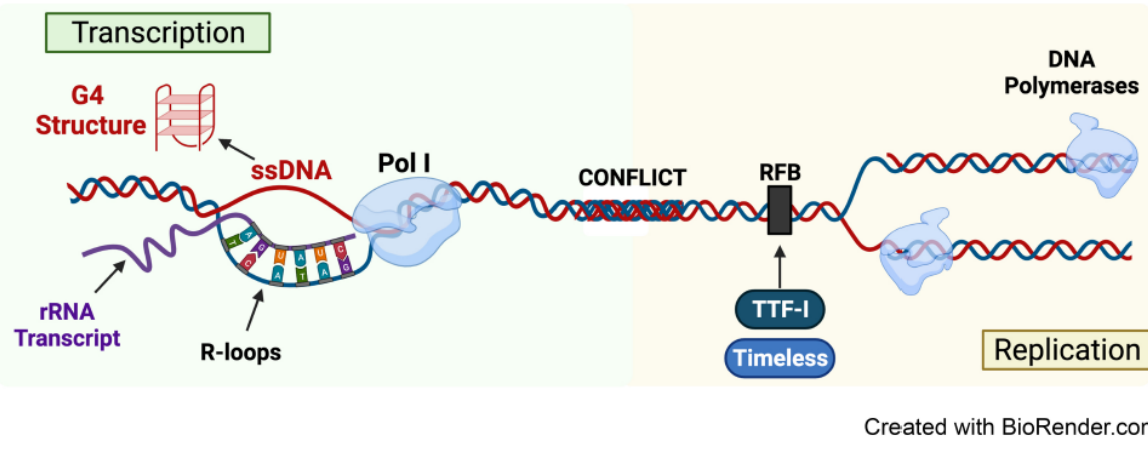
Figure 2. Conflicts between transcription and replication machineries at rDNA. High levels of rDNA transcription cause vulnerability to transcription-replication conflicts. Collisions of Pol I and DNA replication forks trigger positive supercoiling, impinging upon transcription and replication processes at rDNA. Negative supercoiling as a result of unwinding DNA during transcription stabilizes R-loops comprising of stable rRNA transcript and template strand DNA hybrid and displaced single-stranded DNA (ssDNA). G4 structures can form in the displaced ssDNA of R-loops. These unique features drive genomic instability at the rDNA loci. TTF-I and Timeless factor binding to RFB are present as protective mechanisms against potential clashes at early S phase between transcription and replication machineries. Abbreviations: RNA Polymerase I (Pol I), single-stranded DNA (ssDNA), replication fork barriers (RFB), transcription termination factor (TTF-I).